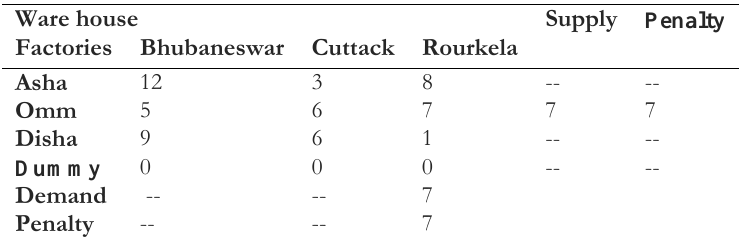
Table 9. Final allocation.